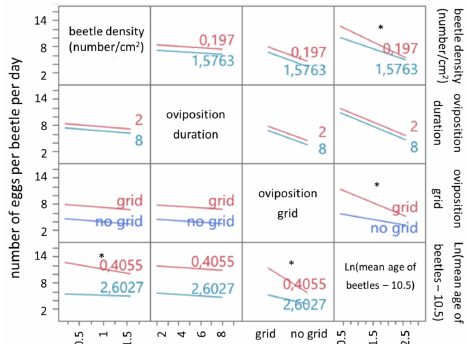
Figure 4. Interaction plots of the linear regression model for the number of eggs per beetle per day of experiment 2. Each interaction plot shows the interaction of the row effect with the column effect. The horizontal axis is scaled for the variable displayed in each column. Lines represent the number of eggs per beetle per day in function of the row variable, for high (blue line) or low (red line) values of the column variable. Values of the column variables are also indicated. Parallel lines indicate the absence of an interaction, while diverging lines indicate the presence of a (non)-significant interaction. Significant interactions ( p < 0.05) are marked by an asterisk (*).